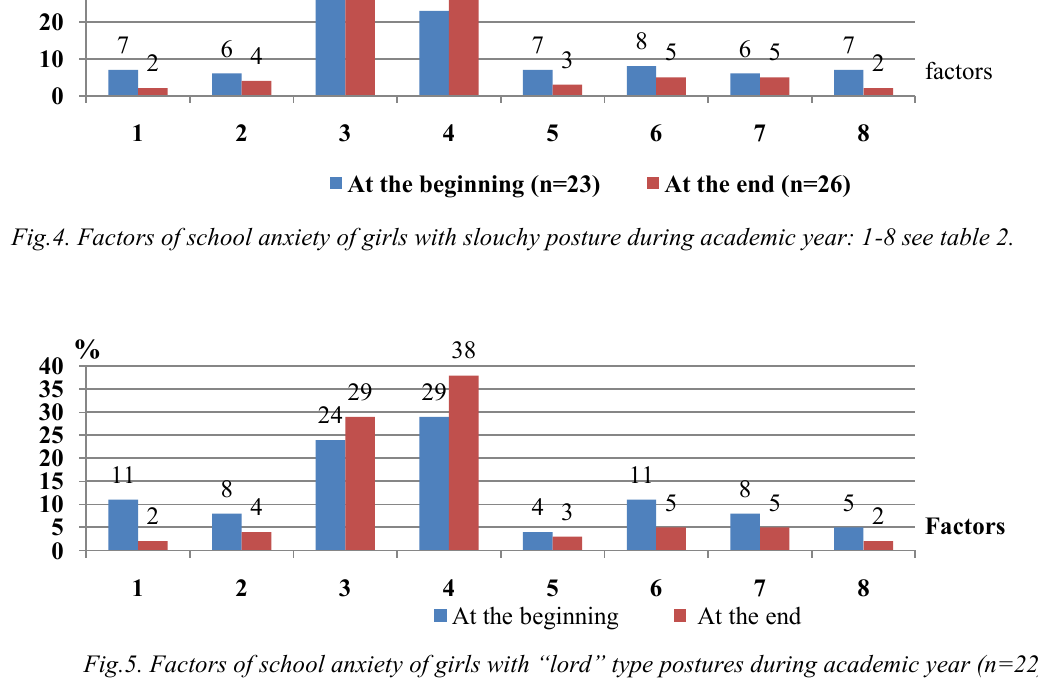
Fig.5. Factors of school anxiety of girls with “lord” type postures during academic year (n=22):